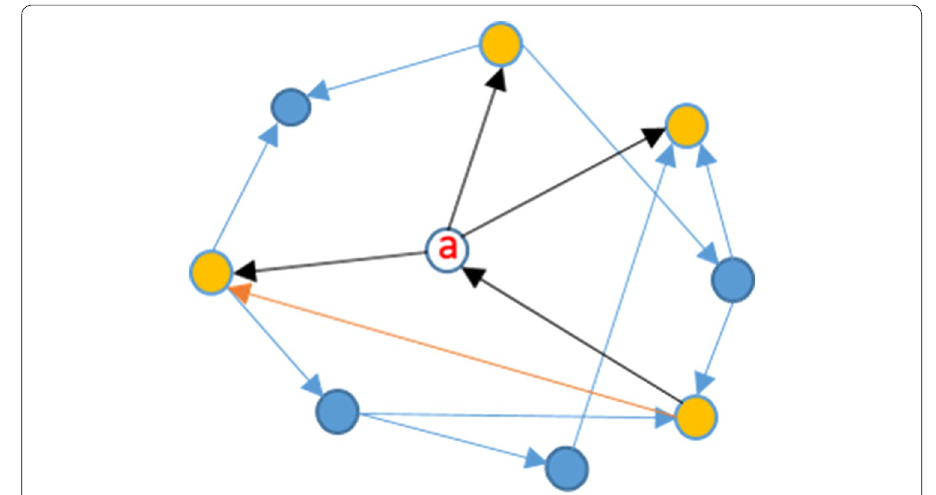
Fig. 4 Clustering coefficient of node ‘a’ in directed